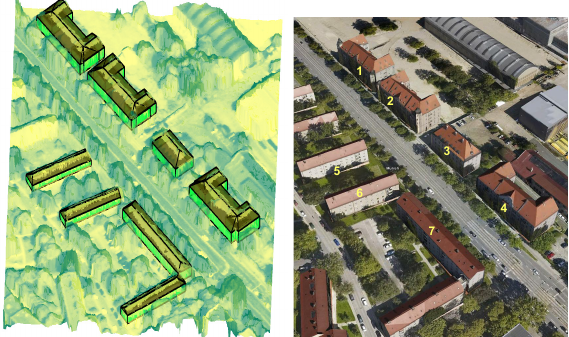
Figure 14: final representation of the 3D models (a) comparing to the Google Earth image